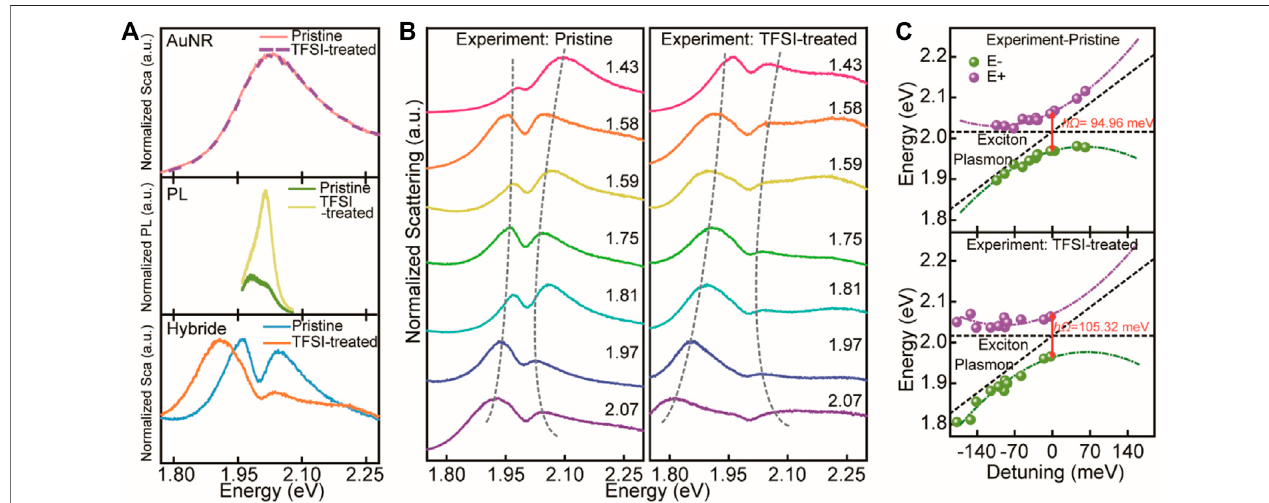
FIGURE 3 | Resonance coupling in individual gold nanorod − WS 2 heterostructures. (A) Scattering spectra of an individual gold nanorod (upper), PL spectra of the monolayer WS 2 (middle), and scattering spectra of an individual heterostructure (lower). (B) DF scattering spectra from different individual heterostructures. Left panel: pristine heterostructures. Right panel: heterostructures upon 0.1 mg/ml-TFSI incubation. Numbers next to the curves indicate the aspect ratios of the gold nanorods in the heterostructures. (C) Scattering peaks as a function of the detuning energy between the LPM and exciton transition energy. Upper panel: pristine heterostructures. Lower panel: heterostructures upon 0.1 mg/ml-TFSI incubation. The horizontal and diagonal black dashed lines indicate the exciton transition energy and LPM energy, respectively. The colored symbols are extracted from the scattering spectra shown in (B) . The colored dashed lines are polynomial fi ttings.